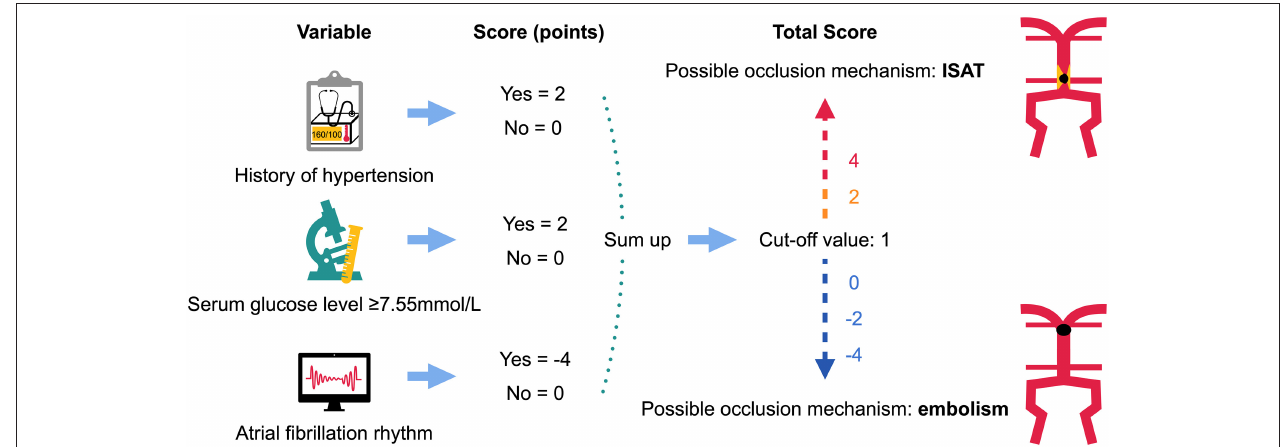
FIGURE 2 | The illustration of the predictive scale on in situ atherosclerotic thrombosis. ISAT, in situ atherosclerotic thrombosis.